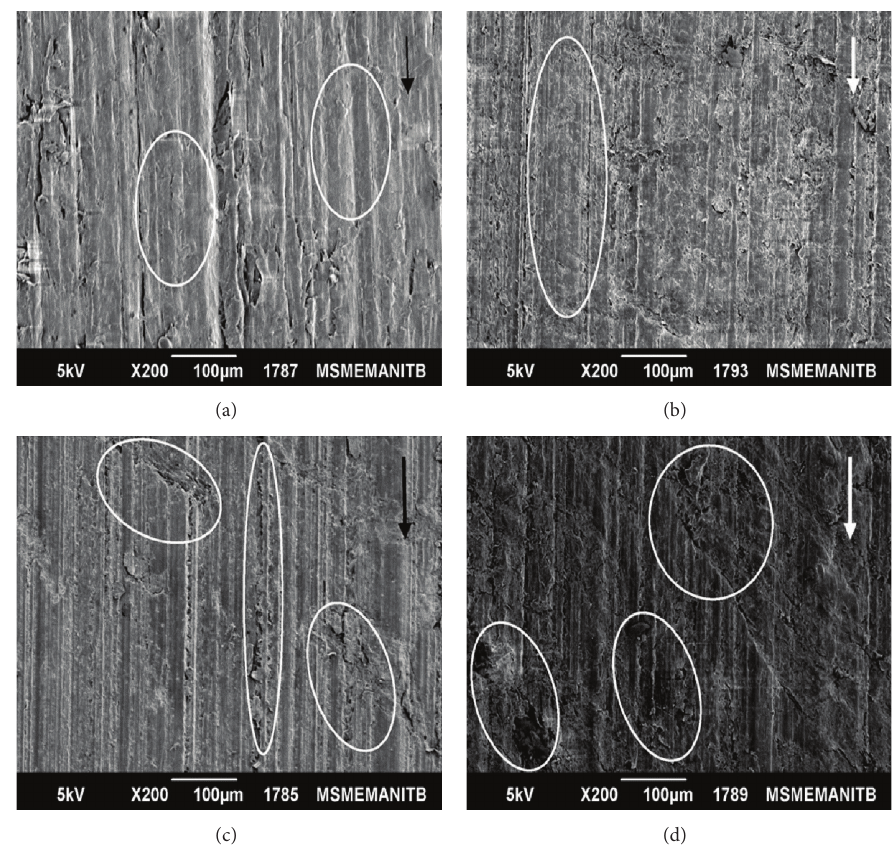
Figure 26: SEM micrographs of maleic anhydride modified RH filled PVC composites: (a) PTRH10 and (b) PTRH30; unmodified RH filled PVC composites: (c) PRH20 and (d) PRH40; with the sliding speed of 10s, sliding distance of 6.28, and applied load of 10N. (P = PVC; T = treated (modified) and downward arrow shows sliding direction)